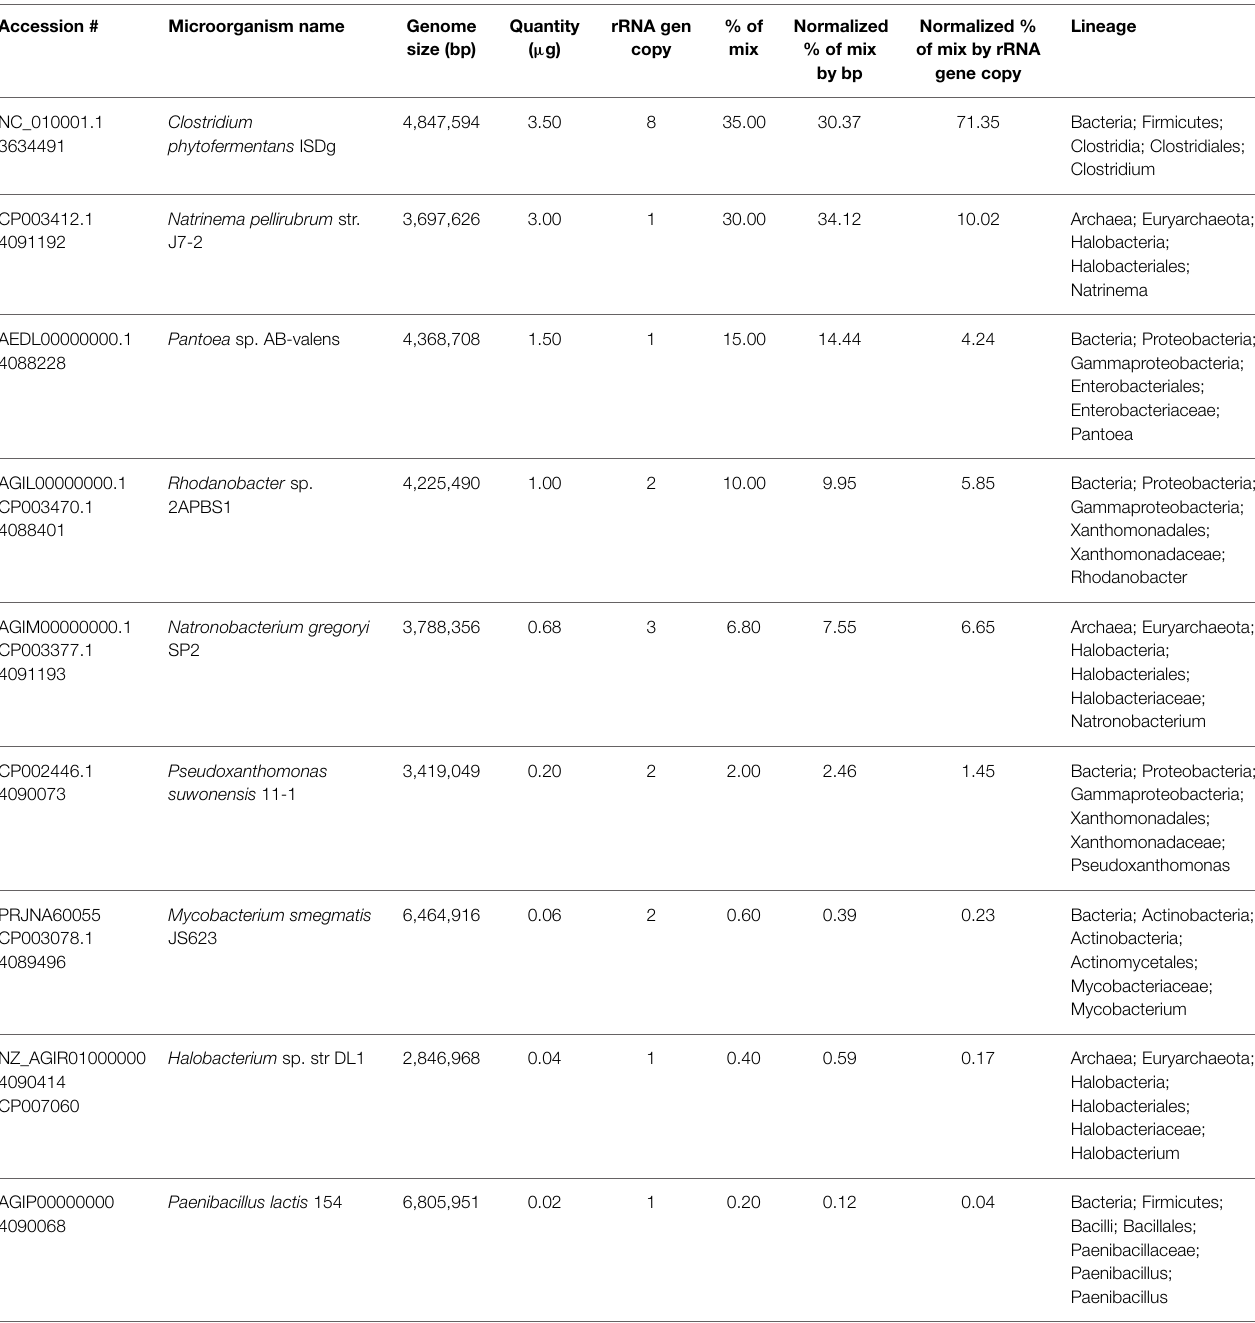
TABLE 2 | Synthetic community microorganism list and expected relative